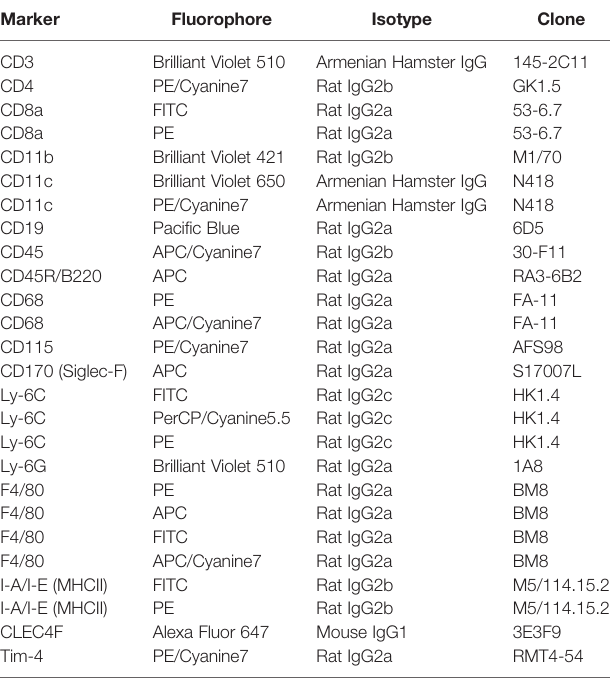
TABLE 1 | List of fl ow cytometry antibodies used in this